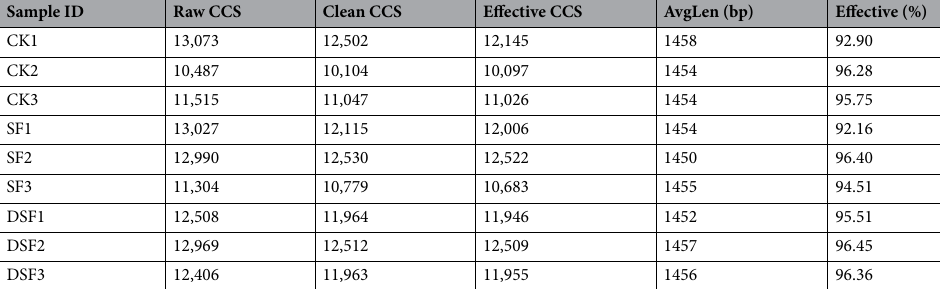
Table 1. Alpha diversity index of rice rhizosphere microorganisms under different fertilization modes of slow-release fertilizer. CCS Circular Consensus Sequencing, Raw CCS was the number of CCS identified by the sample; Clean CCS was the number of sequences after primer removal and length filtering; Effective CCS was the number of sequences used for subsequent analysis after removal of chimera; AvgLen (bp) was the average sequence length of the sample; Effective (%) was the percentage of effective CCS in raw